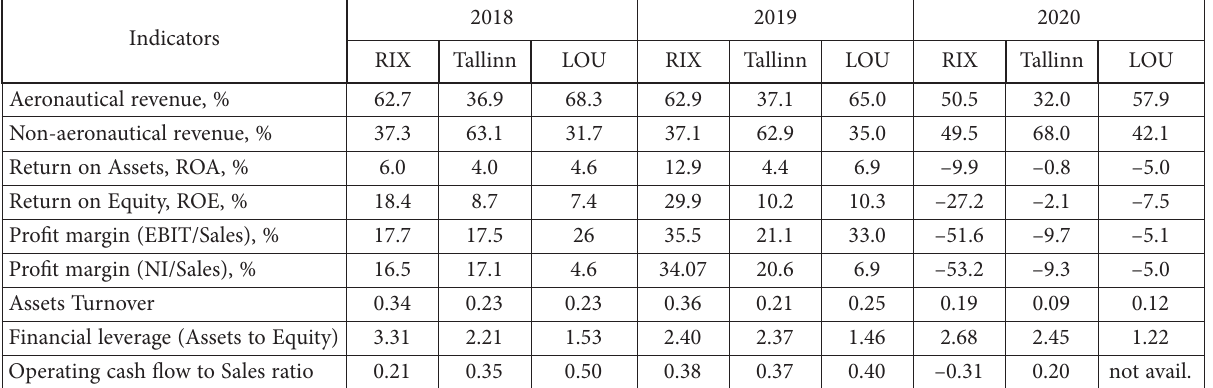
Table 6. Revenue structure and airports’ financial performance (created by the authors)